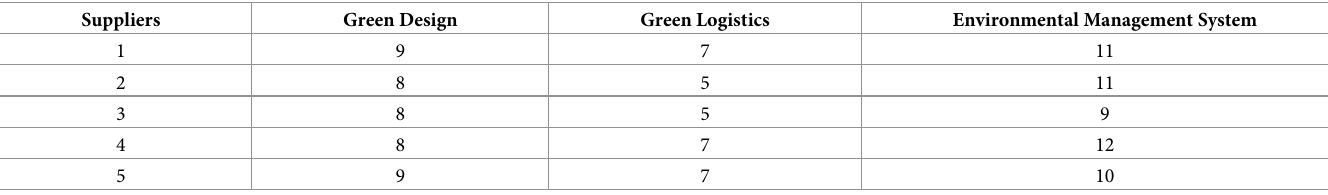
Table 3. Scores of green